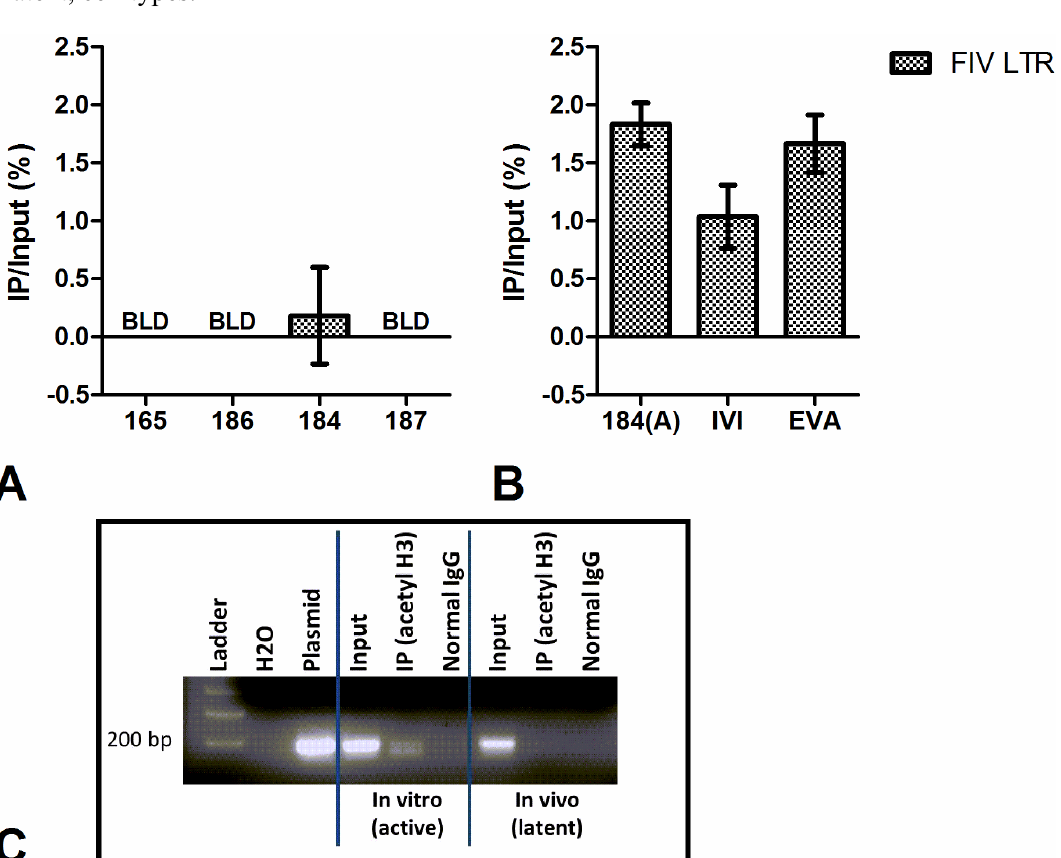
Figure 3. ChIP assay of FIV-infected PBMC using anti-acetylated histone H3 antibody. ( A ) Latently infected (based on undetectable FIV gag RNA) PBMC from three cats were below the limit of detection (BLD) for an association of the FIV LTR with acetylated H3, and detection of this complex for the fourth cat (184) was not significantly different from the background control; ( B ) Productively infected PBMC represented by a period of viral activation in monocytes (184(A)), in vitro infected (IVI) cells, or ex vivo activated (EVA) latently infected cells are all significantly associated with acetylated H3. Data are presented as the percentage of immunoprecipitated (IP) DNA out of the total input DNA (total amount of sheared chromatin DNA used for the assay) with background subtraction using a normal IgG control. Error bars represent the standard deviation of triplicate qPCR measurements, and data is representative of ChIP experiments repeated a minimum of two times between 16 and 29 months post FIV infection; ( C ) A representative gel image of the 180 bp FIV LTR products electrophoresed post real-time PCR for in vitro infected (transcriptionally active) and in vivo -derived (transcriptionally latent) FIV-infected PBMC. The immunoprecipitated (IP) product is detected in transcriptionally active, but not in latent, cell